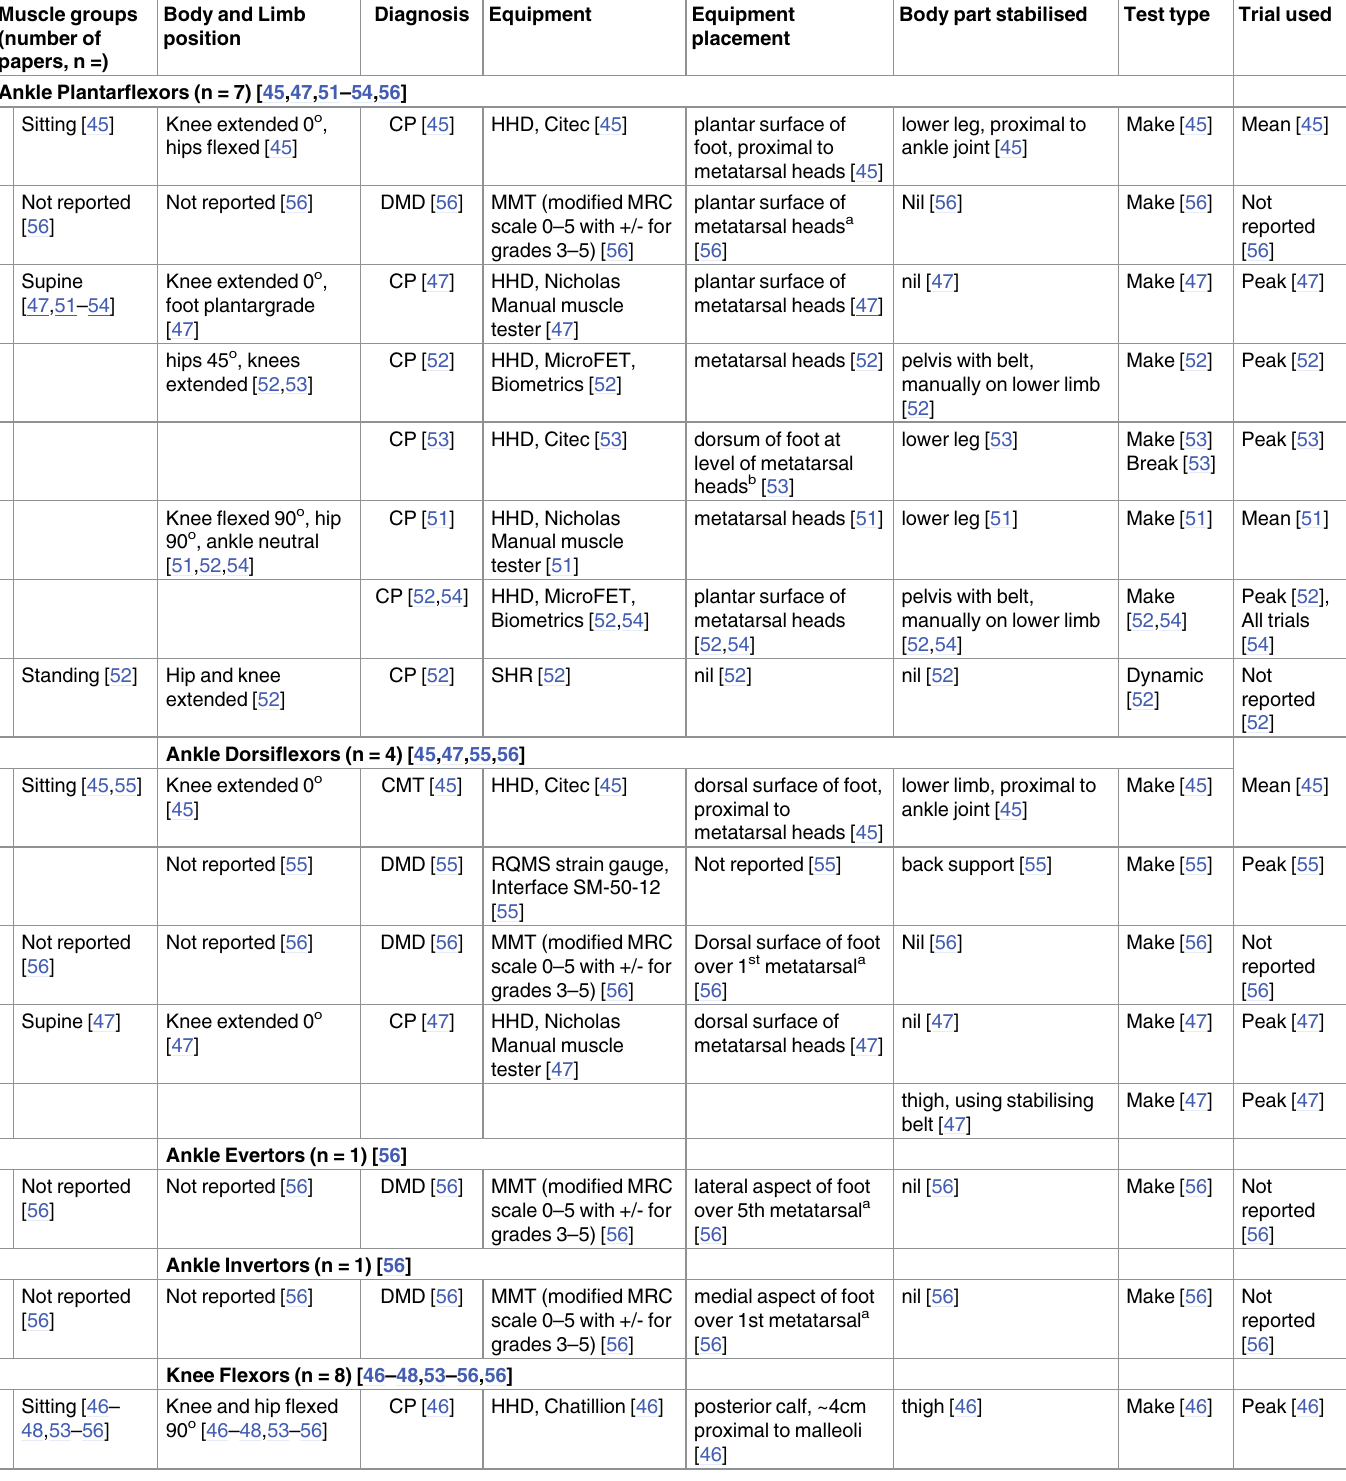
Body part stabilised Test type Trial placement